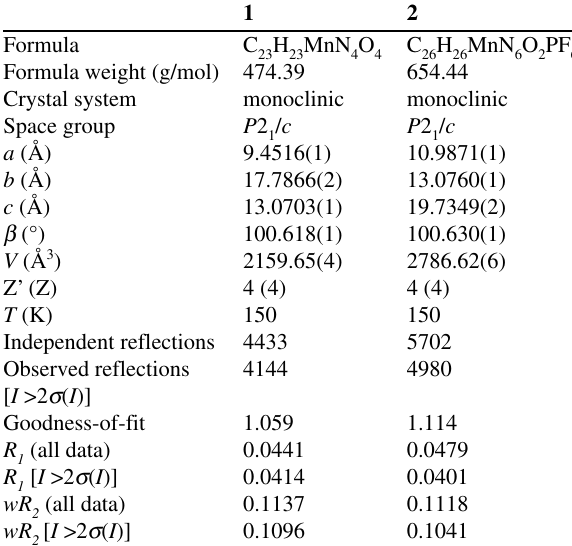
Table 1. Crystallographic data for compounds 1 and 2